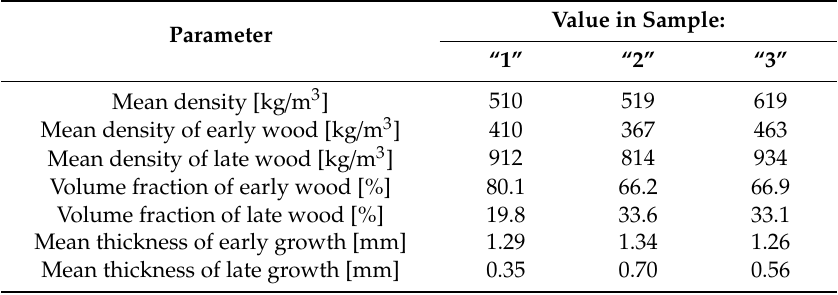
Table 11. Summary of analysis of micro-computed tomography